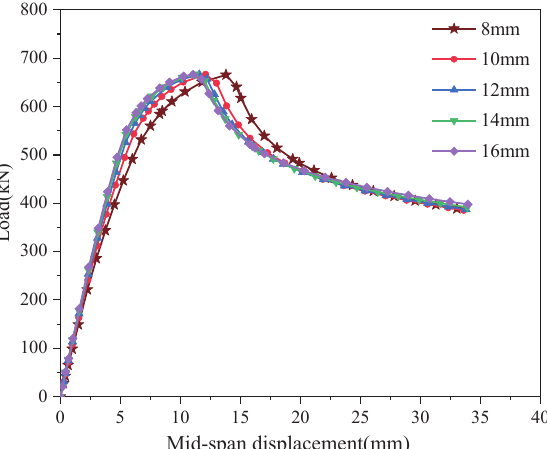
Figure 20. Load-mid-span displacement curves of composite beams with different steel plate thick- nesses when the U-rib thickness is 6